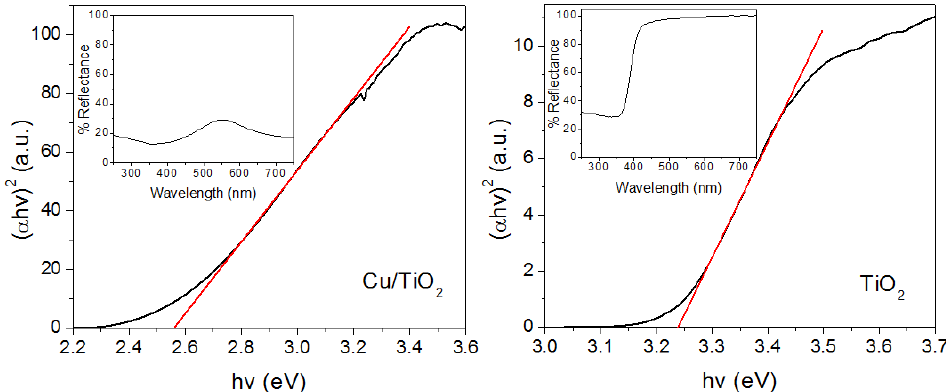
Figure 5. Tauc graphs for band-gap energies of synthesized catalysts. Inset: DRS spectra for each catalyst.